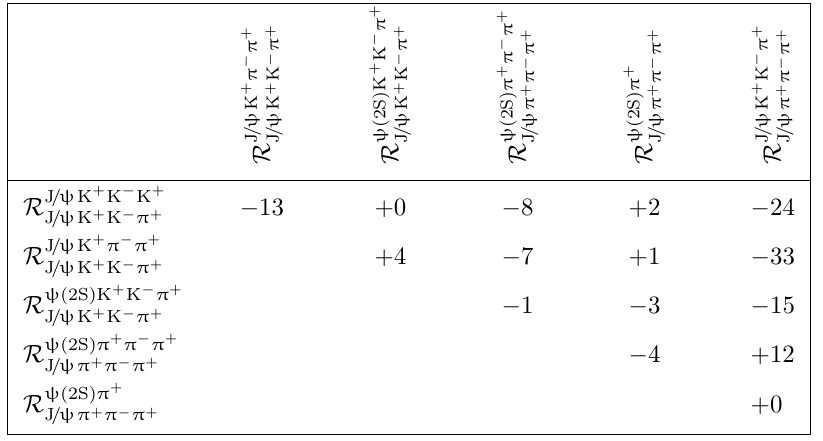
Table 7 . Off-diagonal correlation coefficients ( [%] ) for statistical uncertainties for the measured ratios R X . Y